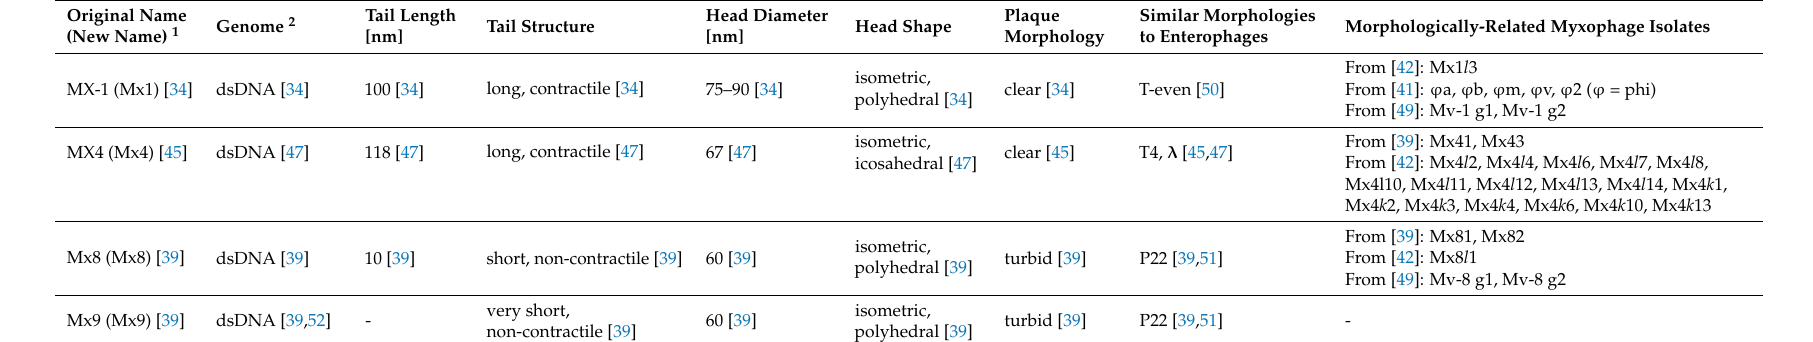
Table 2. Morphological features of well-described bacteriophages of